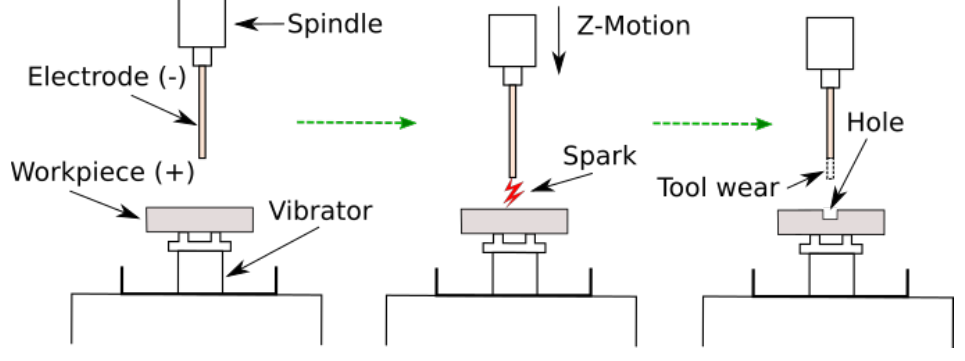
Figure 1. Schematic of microfeature fabrication on 𝜇 -EDM.